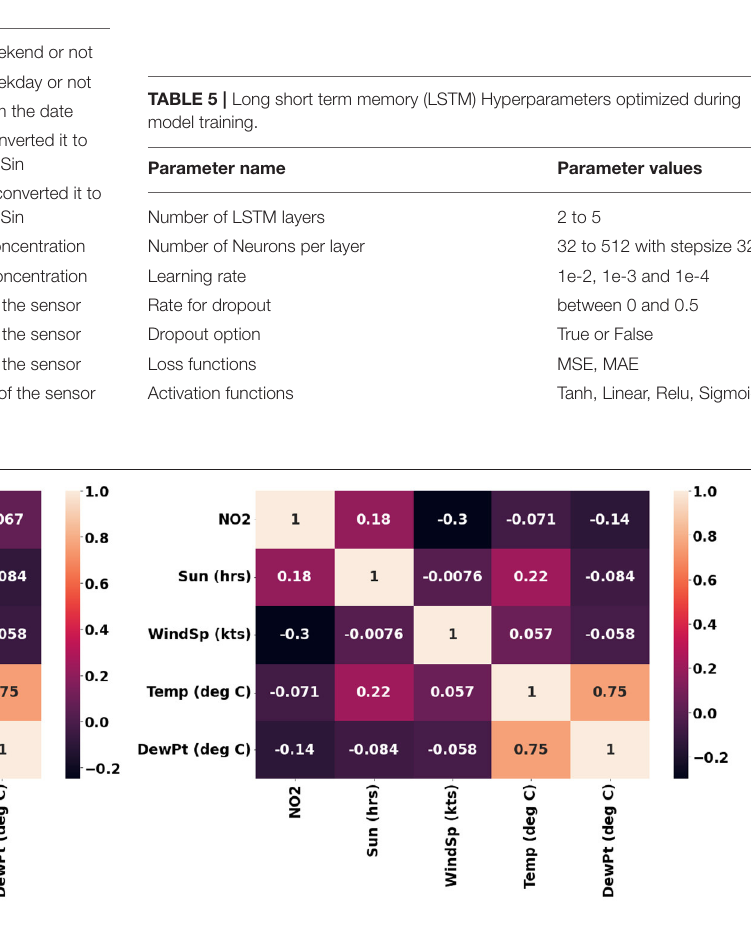
FIGURE 10 | Correlation of the engineered features with regards to PM 10 and NO 2 .